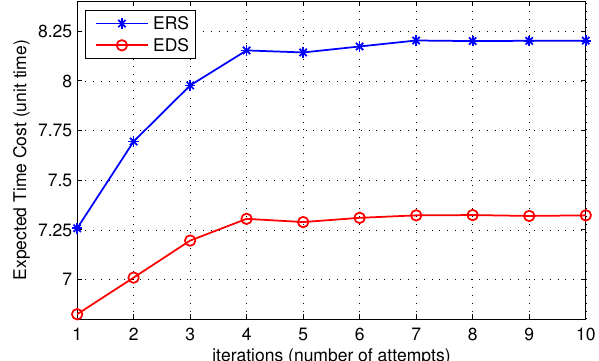
Figure 12. Time cost of ERS and EDS.